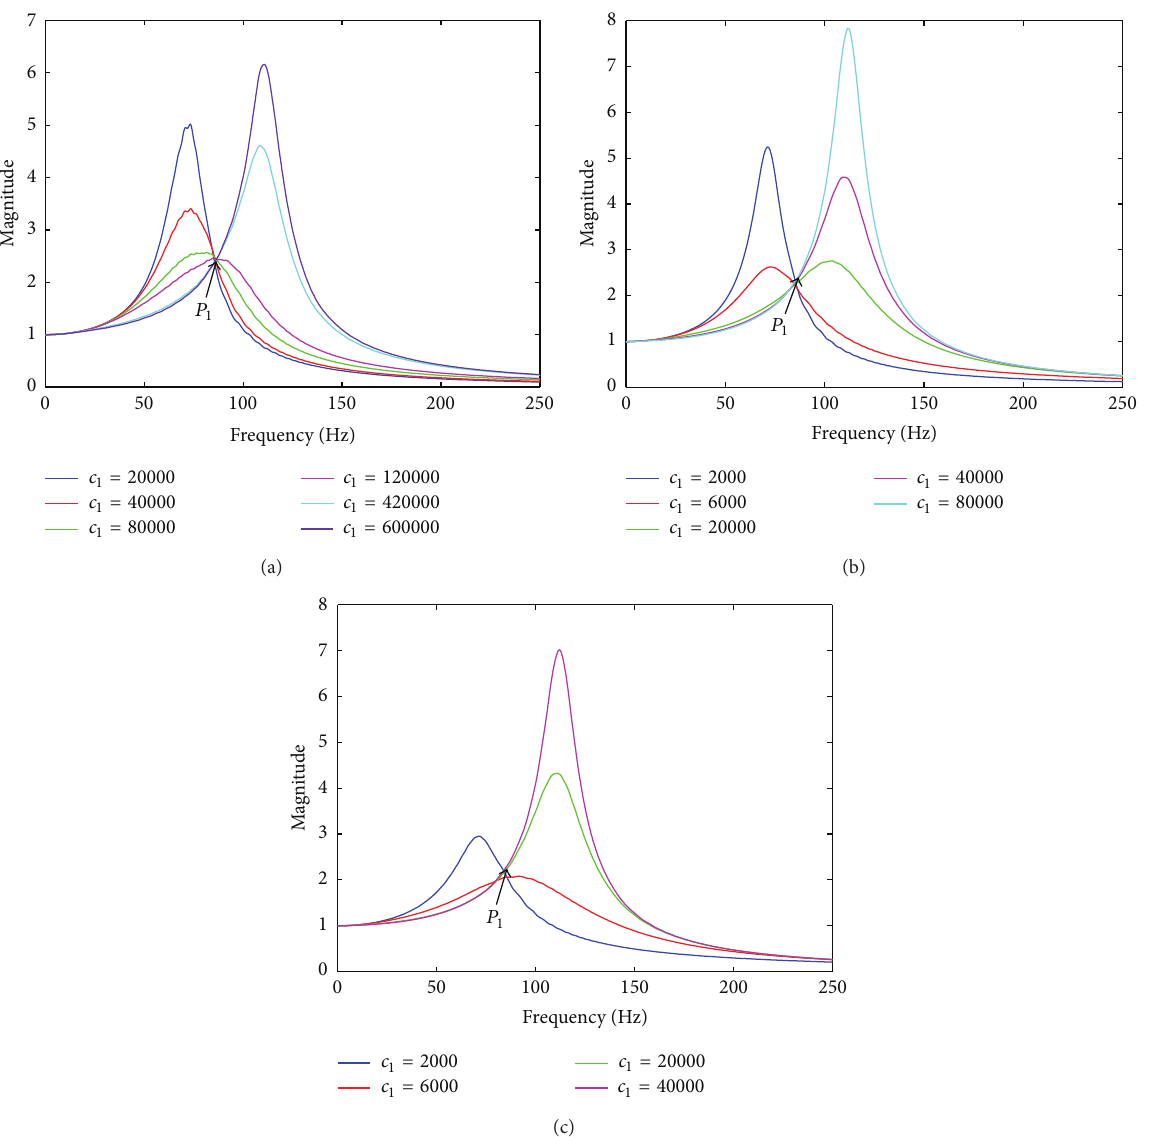
Figure 19: Force transmissibility curves of CM under 100N FE cases. (a) 𝑛 1 = 1.5 ; (b) 𝑛 1 = 1 ; (c) 𝑛 1 = 0.85